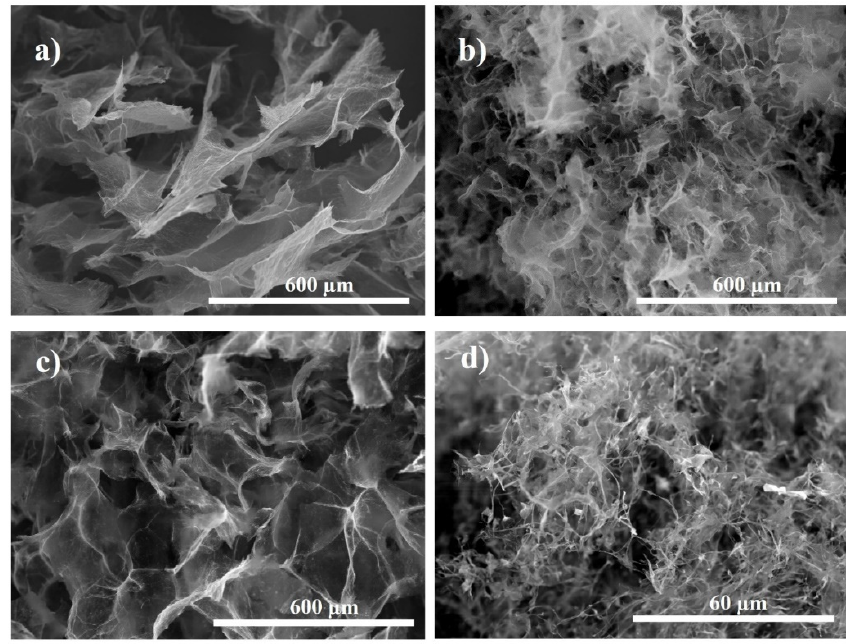
Figure 5. SEM images of un-modified rGO aerogels freeze-cast at: ( a ) − 20 °C and ( b ) − 196 °C and modified with G3 PAMAM freeze-cast at: ( c ) − 5 °C and ( d ) − 196 °C.